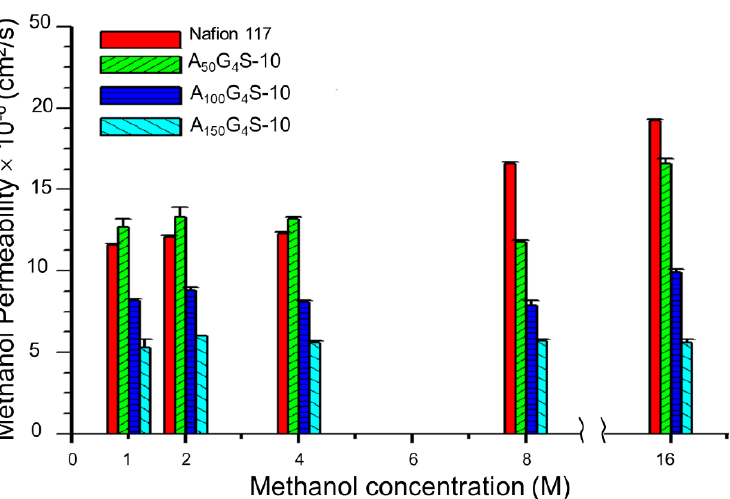
Figure 9. Effect of methanol concentration on the methanol permeability of cross-linked diblock ionomer membranes. A Nafion 117 membrane is included for comparison.